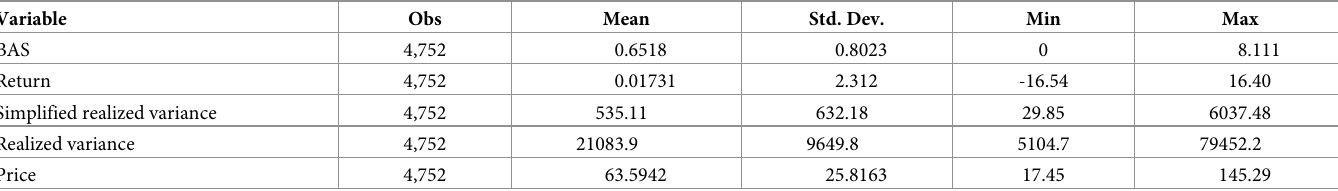
Table 1. Statistical summary of variables used for the 18 year